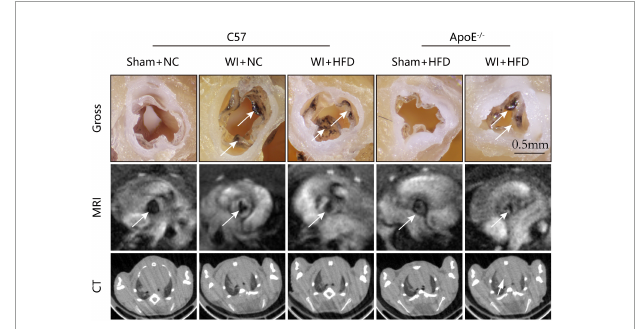
FIGURE2 Aortic valve morphology and calcification examined by MRI and Micro-CT. Representative gross morphology ( top , scale bar, 0.5 mm), MRI images of the aortic valve (middle) , and CT images of aortic calcification (bottom) . The sclerotic leaflets were marked by the white arrow after wire injury in the top panel , the white arrows point toward the aortic valve orifice in the middle panel , and the white arrow indicates the aortic calcification in the bottom panel